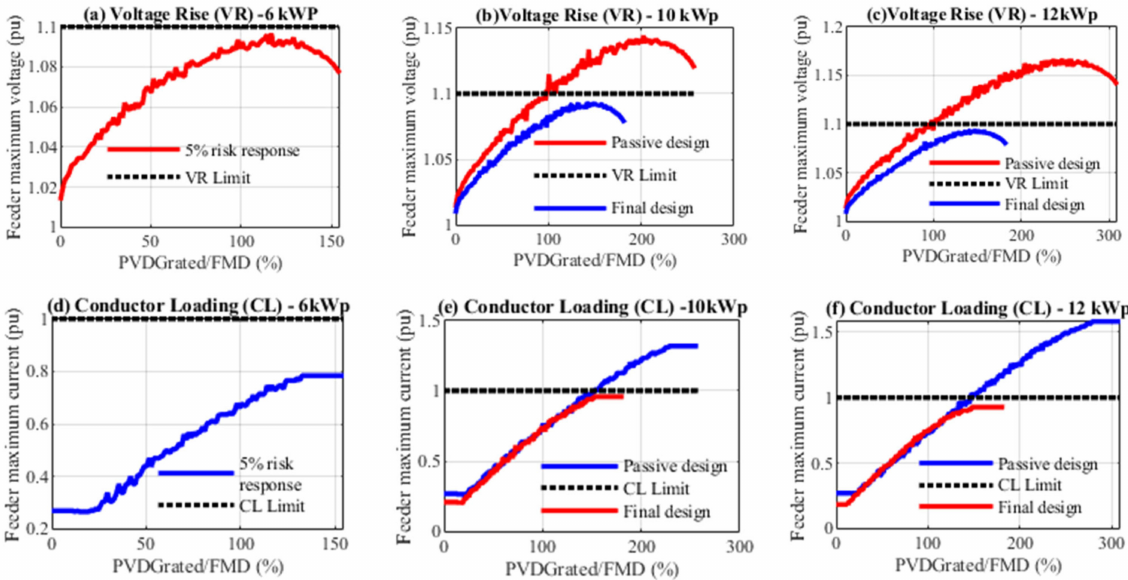
Figure 10. Illustrating the performance response of 6 kWp, 10 kWp, and 12 kWp systems: ( a – c ) illustrates voltage initial and final design performance while ( d – f ) illustrate conductor loading initial and final